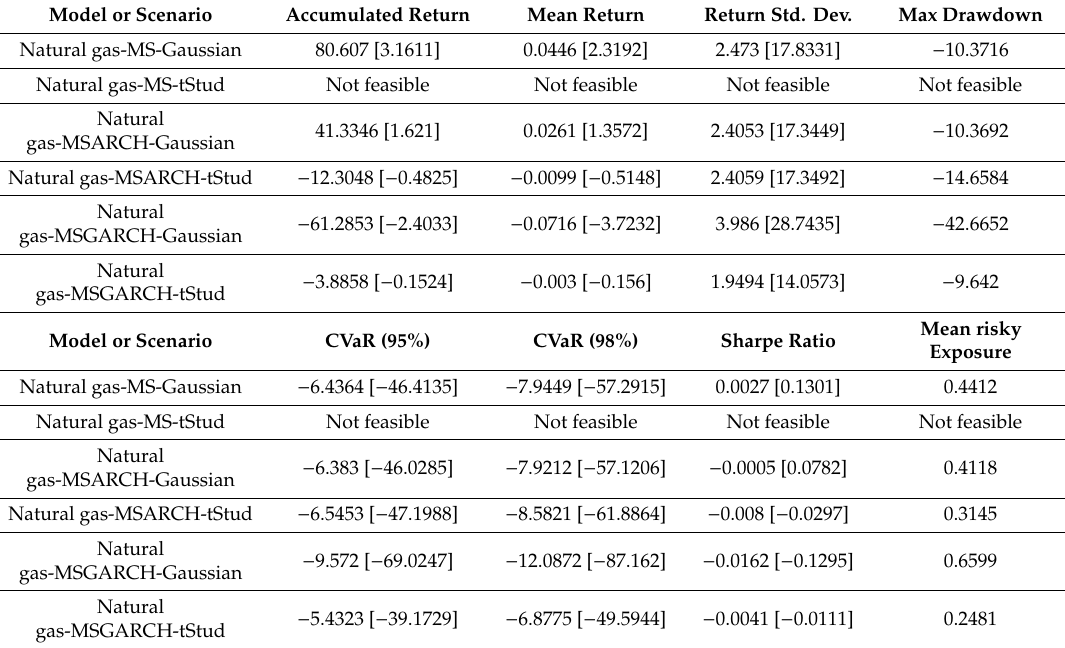
Table 8. Performance of the Markov-switching active investment strategy applied in the continuous one-month natural gas future price